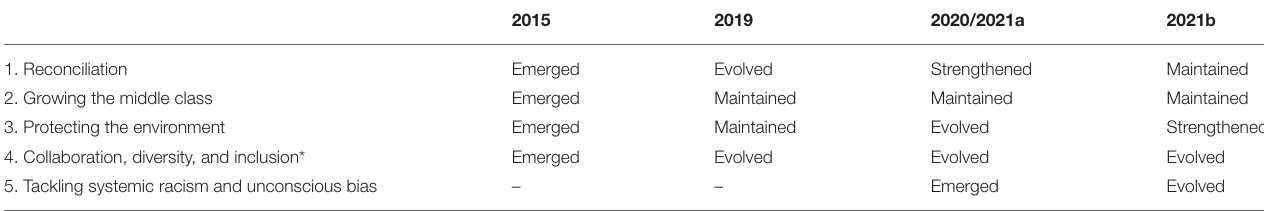
TABLE 2 | Overarching government of Canada narratives from 2015 to